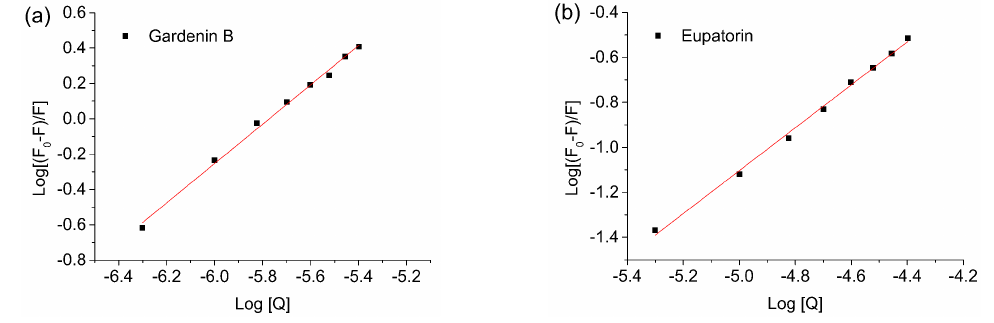
Figure 10. The plots of log[(F 0 − F)/F] versus log[Q] for ( a ) gardenin B and ( b ) eupatorin at 300.15 K.